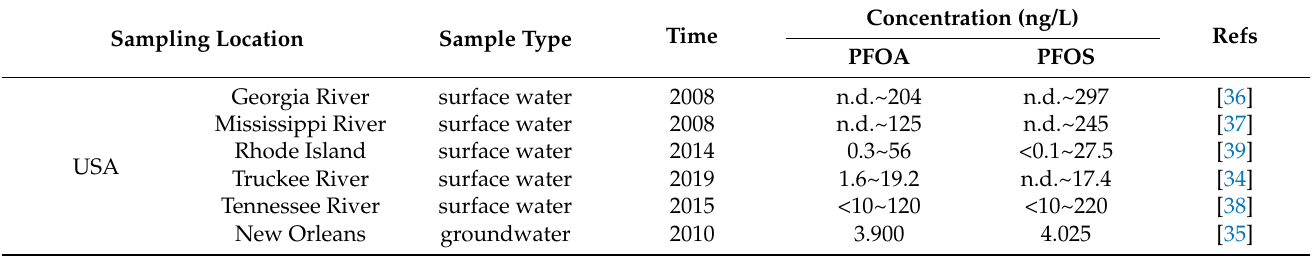
Table 2. Pollution of PFOA and PFOS in the water environment in different countries and